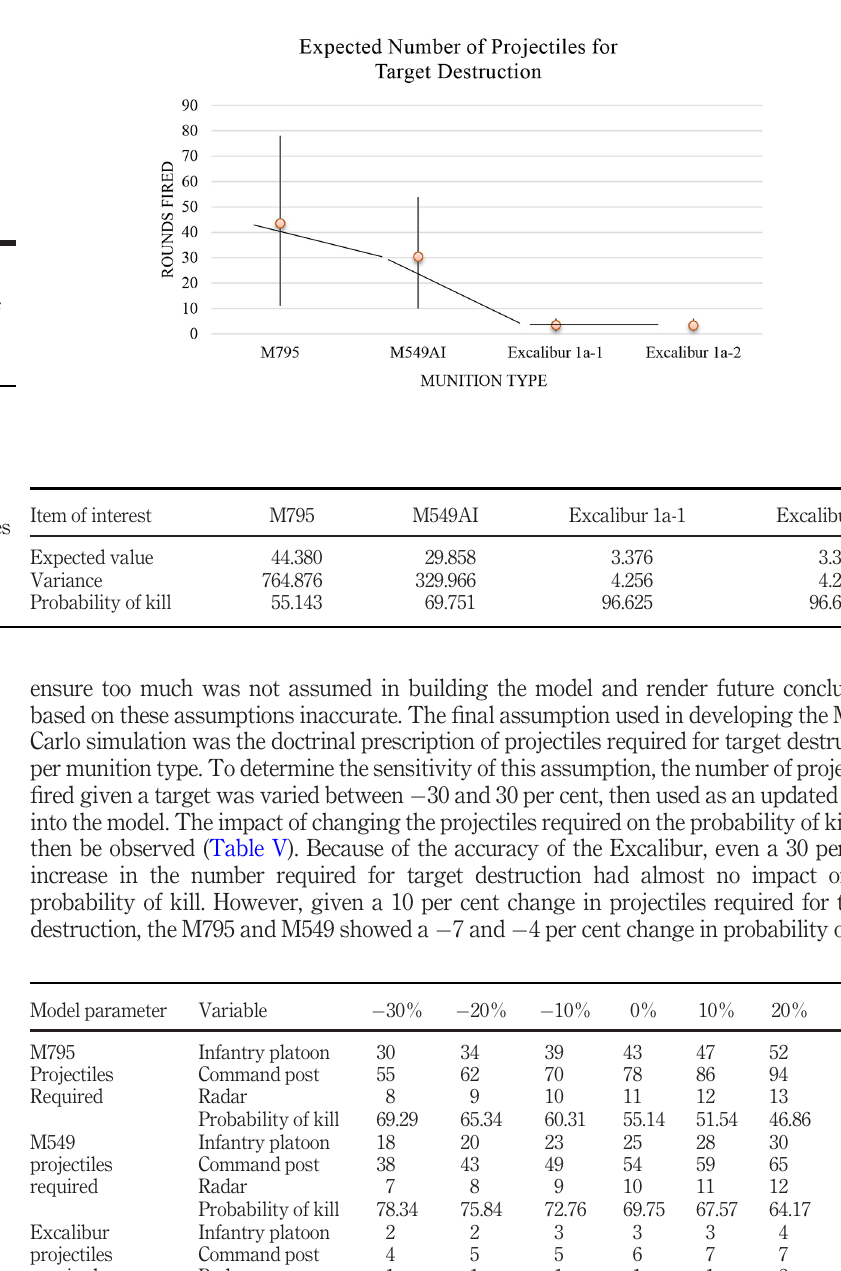
Table V. Monte Carlo simulation probability of kill sensitivity